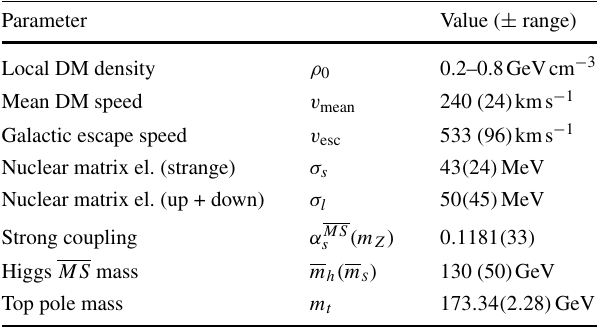
Table 2 Names and ranges of SM, nuclear and halo nuisance param- eters that we vary simultaneously with scalar singlet parameters in our fits. We sample all these parameters using flat priors